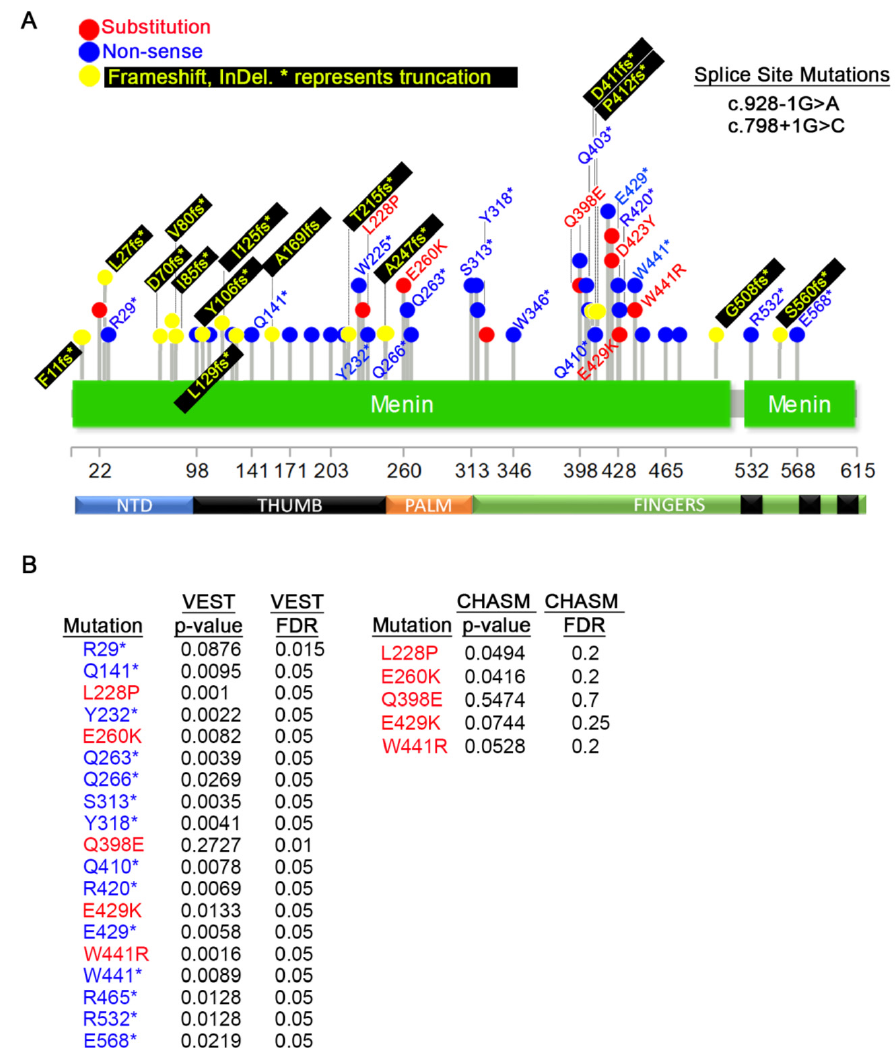
Figure 5. Germline mutations detected in somatic cancers. ( A ) Distribution of all germline mutations that appear on COSMIC. For completion, substitutions and non-sense mutations in pancreas, parathyroid, thyroid, pituitary, and thymus (from Figure 2A) are also shown, but they are not labeled. Only mutations with a significant VEST or CHASM p -value are shown. ( B ) CHASM and VEST p -values for the listed substitutions and non-sense mutations. Calculations for most frameshift and indels were not possible. Only I85fs values were calculated. Probability and False Discovery Rate (FDR) values for mutations already shown in Figure 4B have been excluded.